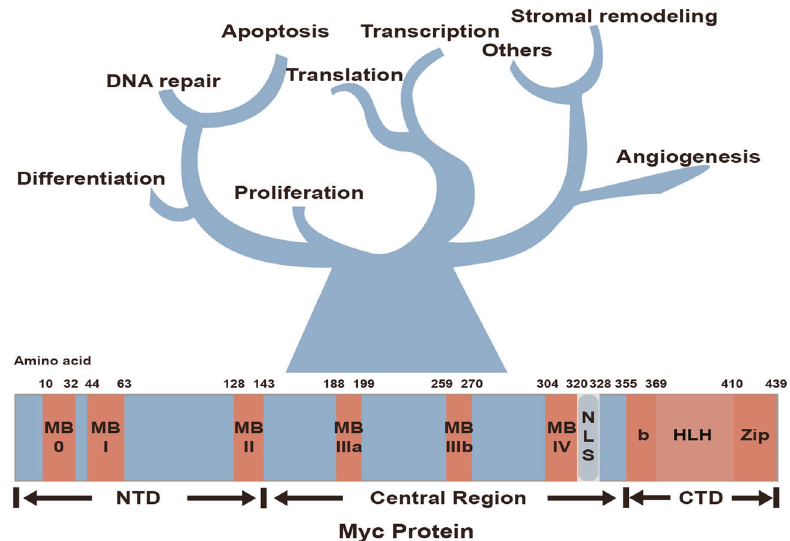
Fig. 1 Structure of Myc protein and its fundamental contributions to diverse biological processes. Myc is comprised of three domains: NTD, central region, and CTD. Highly conserved elements, Myc boxes, are staggered across these domains and involved in the functions of Myc. MBI and MBII carry out the transactivation of Myc target genes, while MB III regulates the stability of Myc. The BR/HLH/LZ motif at CTD is related to the heterodimerization with Max and DNA – protein interaction. The physiological transcription factor Myc thrives diverse fundamental biological processes, including proliferation, differentiation, transcription, translation, apoptosis, angiogenesis, DNA repair, and stromal remodeling